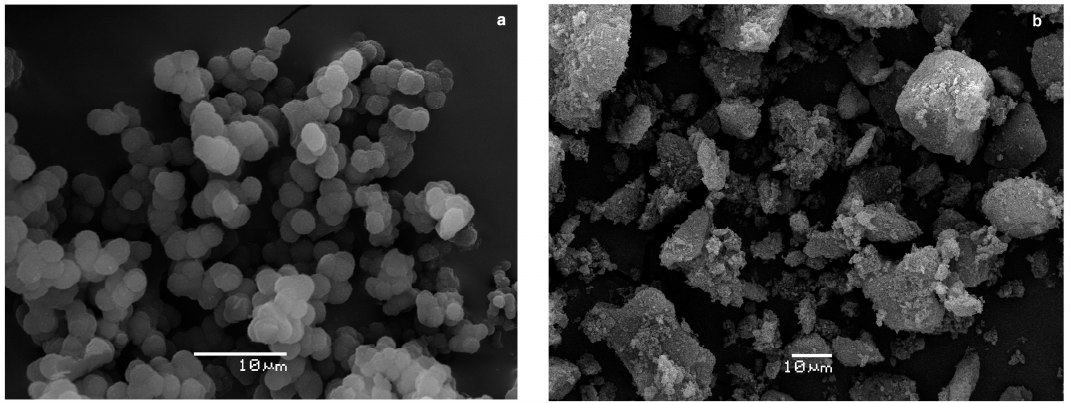
Figure 3. SEM microscopies of ( a ) miniMIP 1; ( b ) miniMIP 3 for BPA.